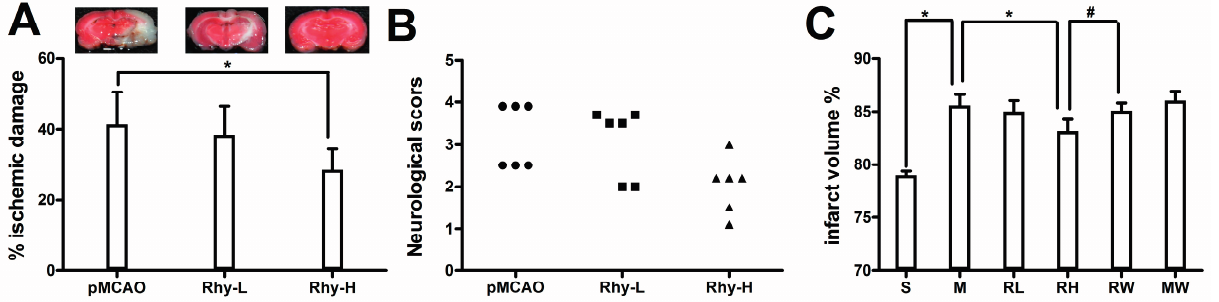
Figure 1. Rhynchophylline attenuated the ischemic damage after pMCAO. ( A ) The bar graph represents the mean ± SE of the ischemic lesion volume. The microphotographs show representative brain slices ( * p < 0.05 vs. pMCAO); ( B ) The scatter graph shows the individual score for neurological deficits; ( C ) The graph shows the percentage of brain edema in Sham (S), pMCAO (M), Rhy-L (RL), Rhy-H (RH), pMCAO + wortmannin (MW) and Rhy-H + wortmannin (RW) groups ( * p < 0.05 Rhy and Sham vs. pMCAO, # p < 0.05 RW vs.